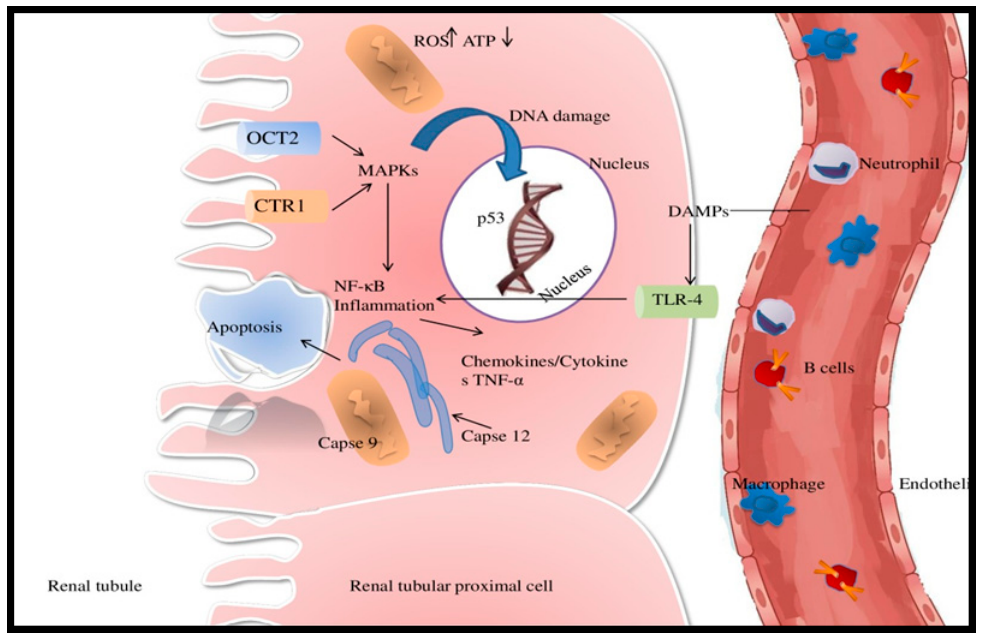
Figure 3. The complex mechanisms of cisplatin-induced acute kidney injury (AKI). Adenosine triphosphate (ATP); copper transporter 1 (Ctr1)(CTR1); damage-associated molecular pattern molecules (DAMPs); mitogen-activated protein kinase (MAPK); nuclear factor kappa-light-chain-enhancer of activated B cells (NF- κ B); organic cation transporter (OCT2); reactive oxygen species (ROS); toll-like receptor-4 (TLR-4); tumor necrosis factor alpha (TNF- α ). Various pro-inflammatory cytokines and interleukins are secreted in the process, including IL-1, 1 β , 6, 18, CXCL1, 8 and CCL2, 5, 10. Detecting them may be helpful in early AKI diagnosis in